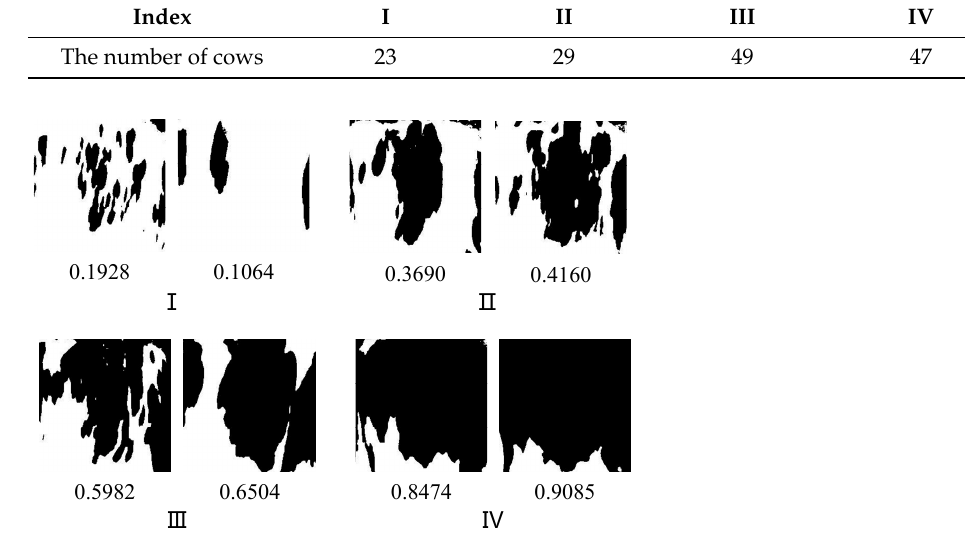
Table 2. Training accuracy of the four categories